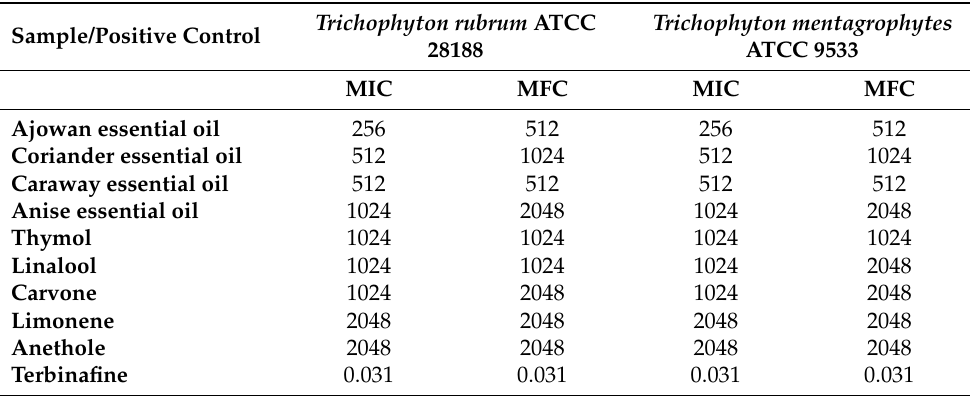
Table 2. Antifungal activity (MIC, MFC expressed as mg/L) of Apiaceae essential oils and their main